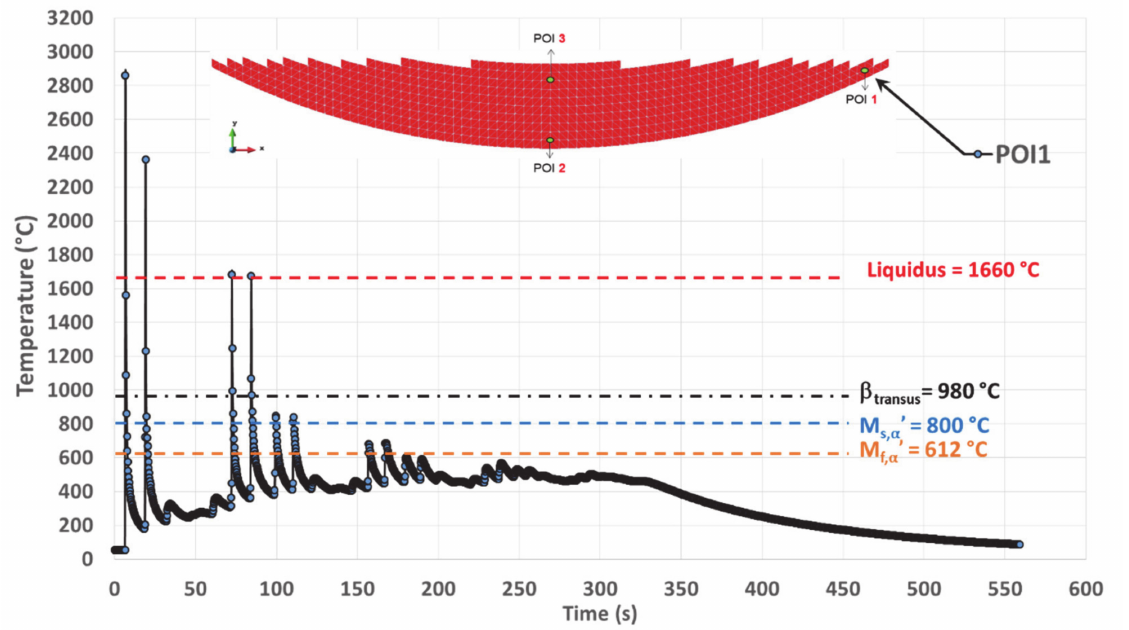
Figure 10. Simulated thermal history of POI1, starting from the material deposition, up to the final cooling at the end of